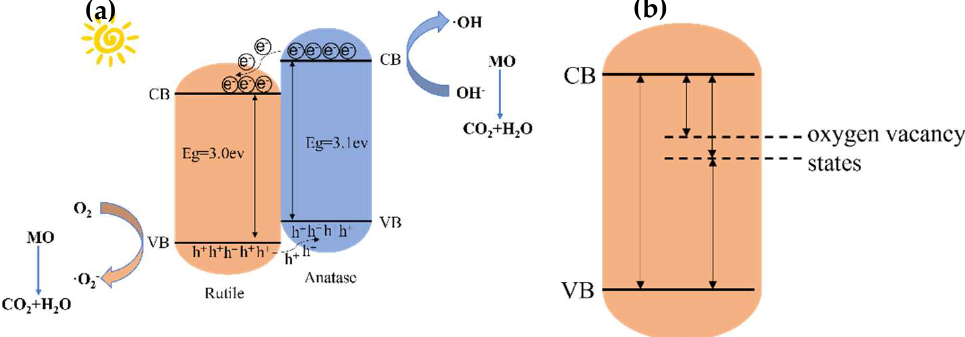
Figure 12. ( a ) Photocatalytic mechanism before plasma treatment; ( b ) photocatalytic mechanism after plasma treatment.